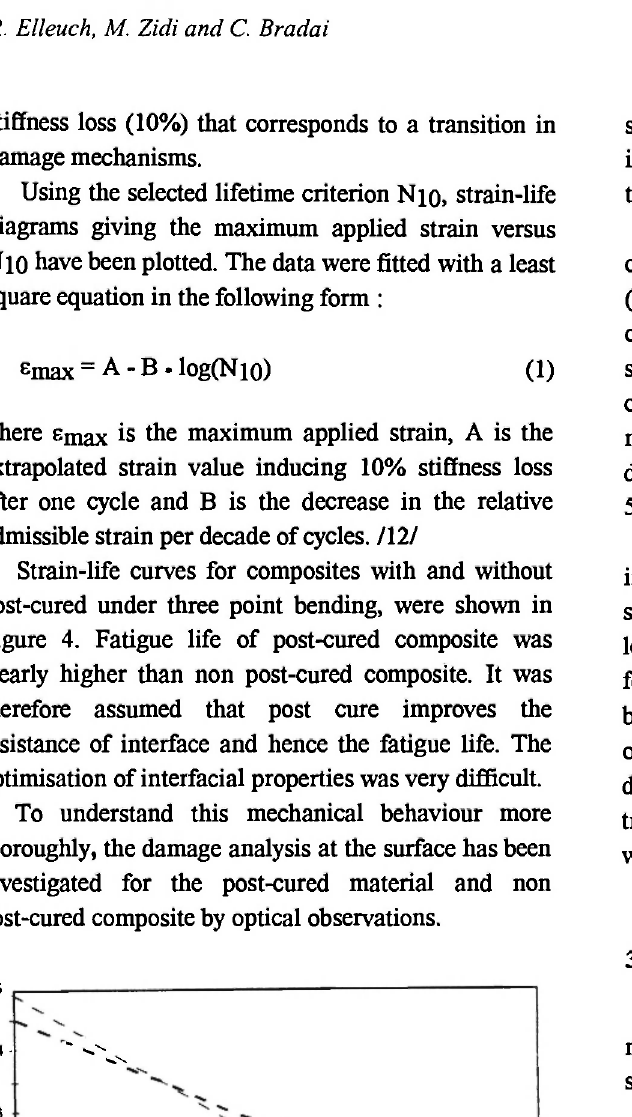
Fig. 4: Strain-life curves for composites with and without post-cured under three point